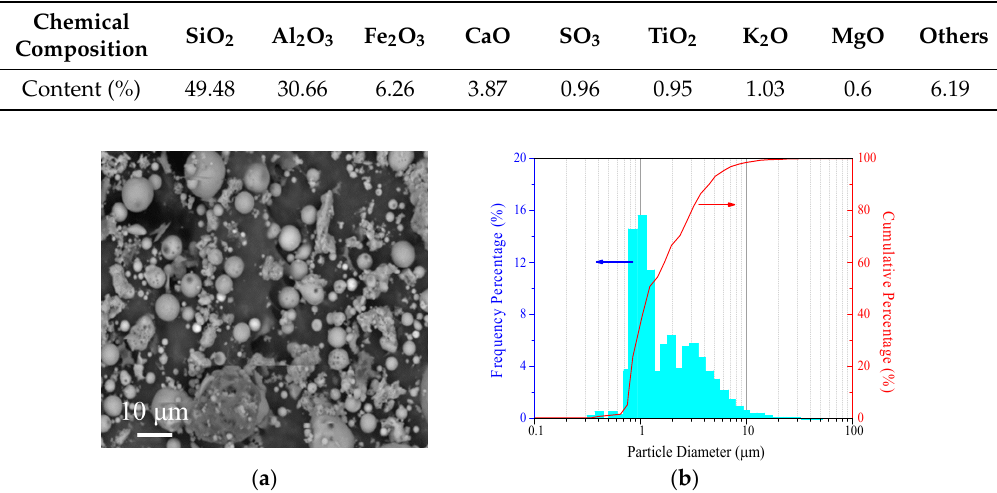
Figure 4. Analysis of ultrafine coal fly ash (CFA): ( a ) SEM image; ( b ) particle size analysis. Table 1. Chemical composition analysis of ultrafine